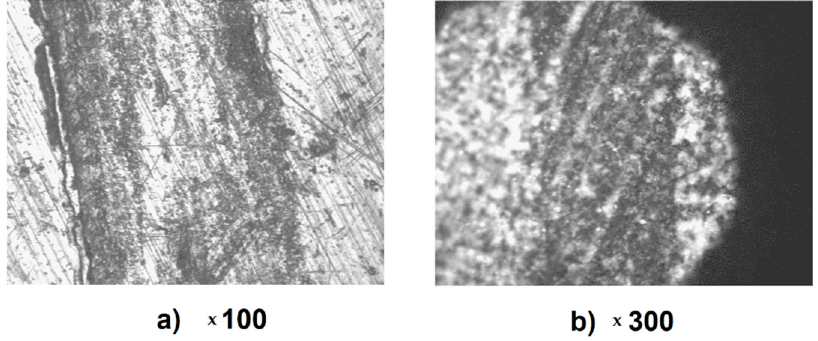
Figure 6. Stuffed material specimens with cure times of 20 min at zoom of ( a ) ×100 and ( b ) ×300.